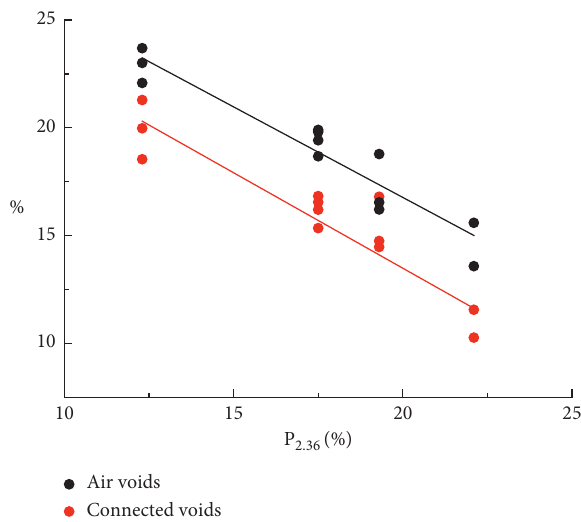
Figure 7: The relationship between passing rate of 2.36mm screen hole and voids percent and connected voids percent, respectively.